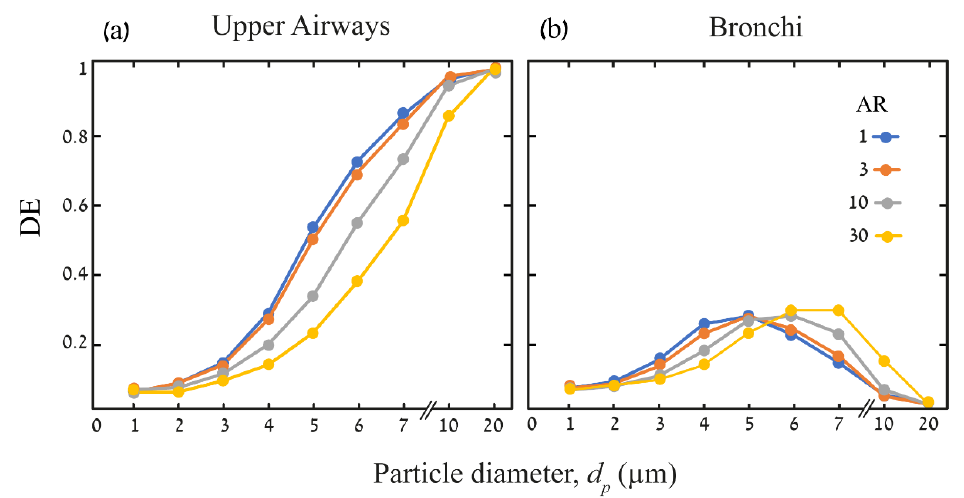
Figure 4. Deposition efficiencies (DE) in upper airways model ( a ) and the bronchial bifurcating tree ( b ) as a function of d p and AR at the end of the DPI maneuver ( t = 3 s). ( a ) As d p increases, particles deposit more and a significant effect of AR only appears for particles larger than 4 µm; as AR increases, DE decreases. For 20 µm particles, DE ~ 1 without observable differences between spheres and fibers. ( b ) DE in the bronchial tree is calculated by reducing the particles that already deposit in upper airways; therefore, an optimum is achieved for deposition in the bronchi. While small particles ( d p < 3 µm ) are screened through the domain due to convection, large particles ( d p =10–20 µm) deposit in the upper airways due to inertial impaction and gravitational sedimentation. The optimum for particles deposition in the bronchi changes with AR , such that 5 µm spheres reach DE ~ 0.26 and 7 µm fibers of AR = 30 reach DE ~ 0.3.